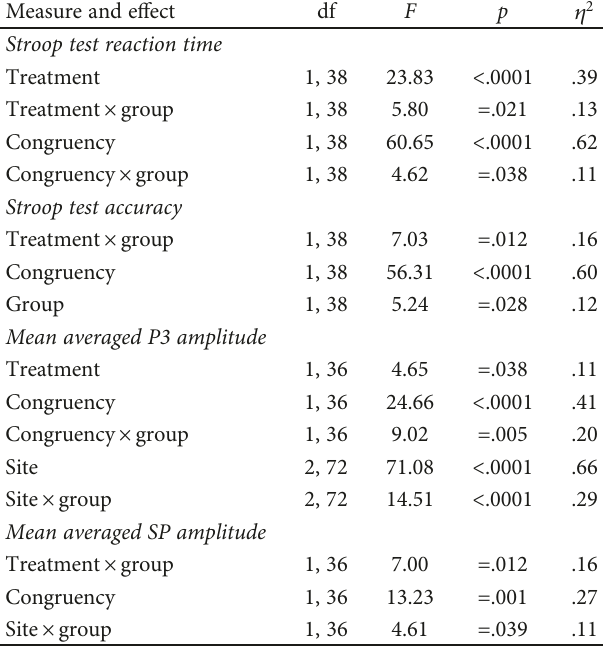
Table 2: Summary of statistical analyses of behavioral and ERP